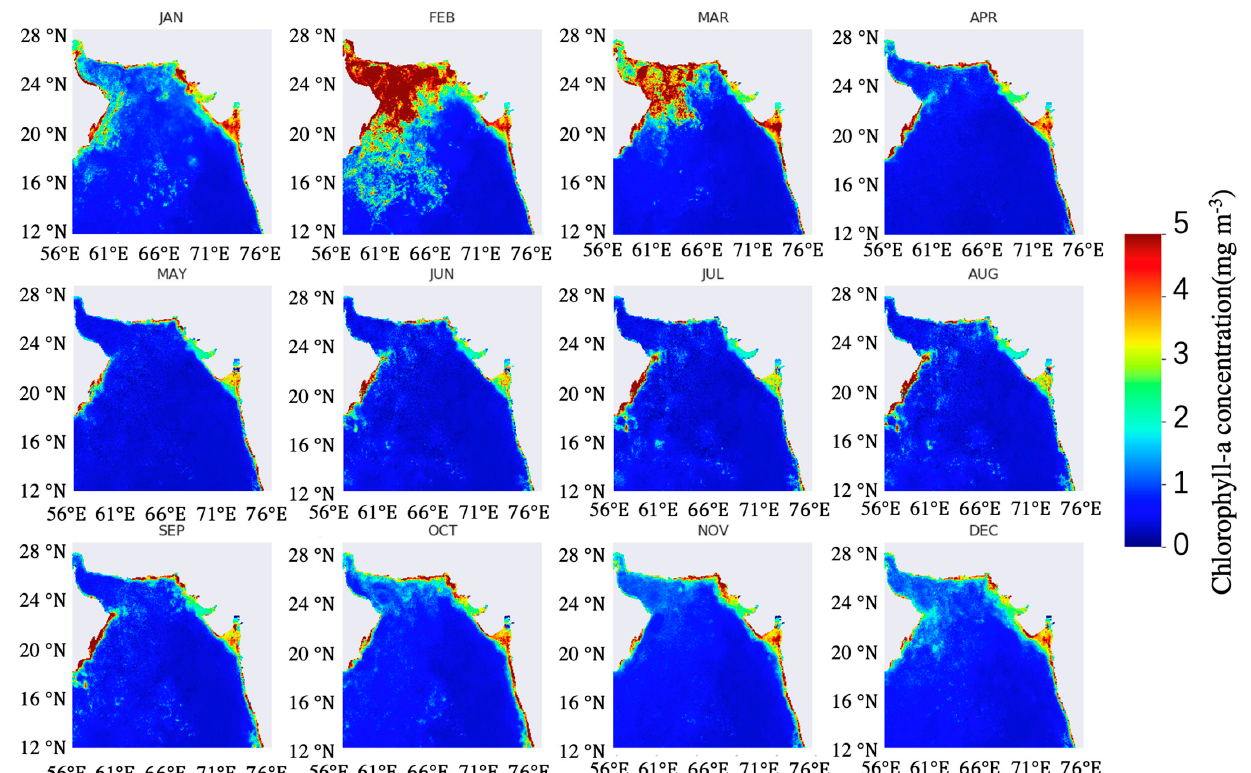
Figure 12. Monthly interpolation results for Chl − a with the DINCAE − BME from January to December 2021.